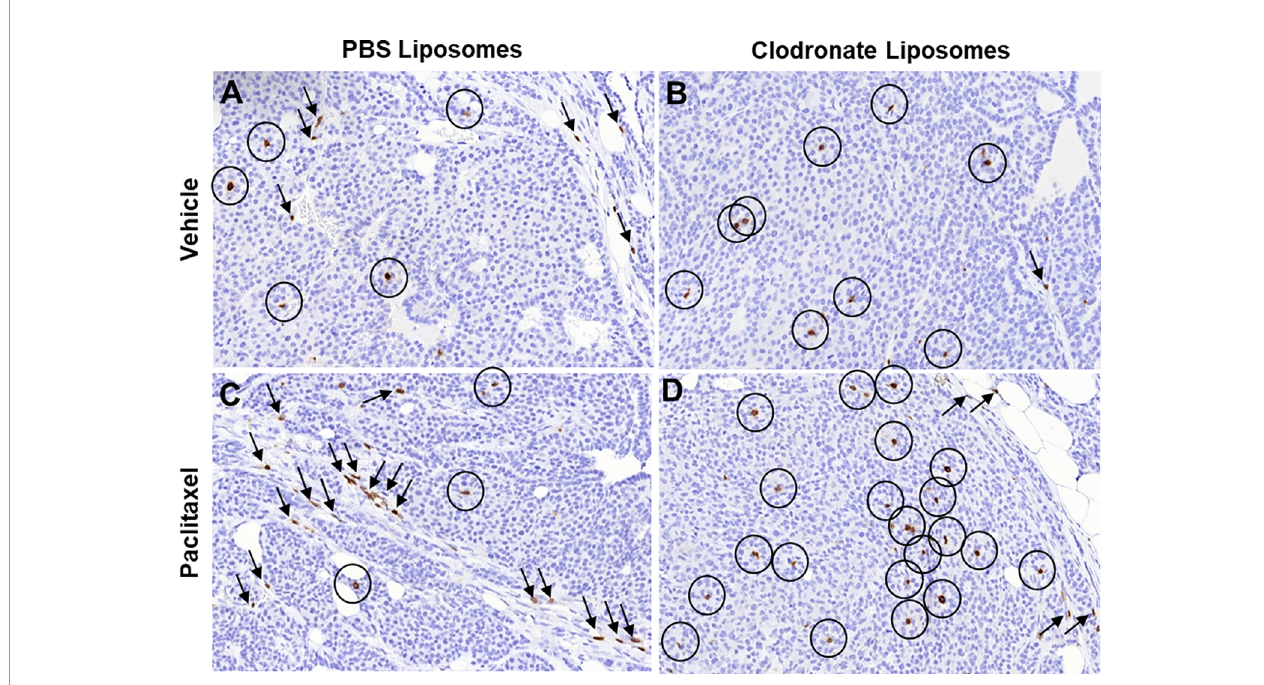
FIGURE 2 | Immunohistochemical indication of how different pharmacologic modi fi cations of the immunosuppressive tumor microenvironment may affect T cell traf fi cking into tumors. (A – D) Immunohistochemistry for T cell speci fi c marker CD3 in tumor sections from mouse mammary tumor virus – polyoma middle T antigen (MMTV-PyMT) mice, developing spontaneous breast carcinomas. The images are high power fi elds (x40), representative from a total of three mice in each experimental condition. Circles, CD3 + T cells in fi ltrating the tumor nests; Arrows, CD3 + T cells in fi ltrating the tumor stroma. Notice the signi fi cant changes in intratumoral versus stromal T cell in fi ltration upon different treatments that modify the immunosuppressive microenvironment.) In breast carcinoma, T cells are found in both tumor cell nests and the tumor stroma (A) . Upon macrophage depletion with clodronate liposomes, most T cells can leave the stroma and penetrate the tumor cell nests (B) . However, treatment with cytotoxic chemotherapy is known to induce lymphocyte in fi ltration and signi fi cantly larger number of T cells is found compared to the vehicle (C) . Notably however, most of these T cells are restricted in the tumor stroma, as chemotherapy attracts immunosuppressive myeloid cells at the same time, resulting in lymphocyte exclusion (C) . If such immunosuppressive myeloid cells are depleted through clodronate liposomes in chemotherapy- treated tumors, the increased in fl ux of T cells is now relocated in the tumor nests (D) . Immunohistochemistry was performed in archival tissue from experiments originally conducted in the manuscript by Karagiannis et al. (139) , in which ethical approval for the use of the experimental mice was also obtained